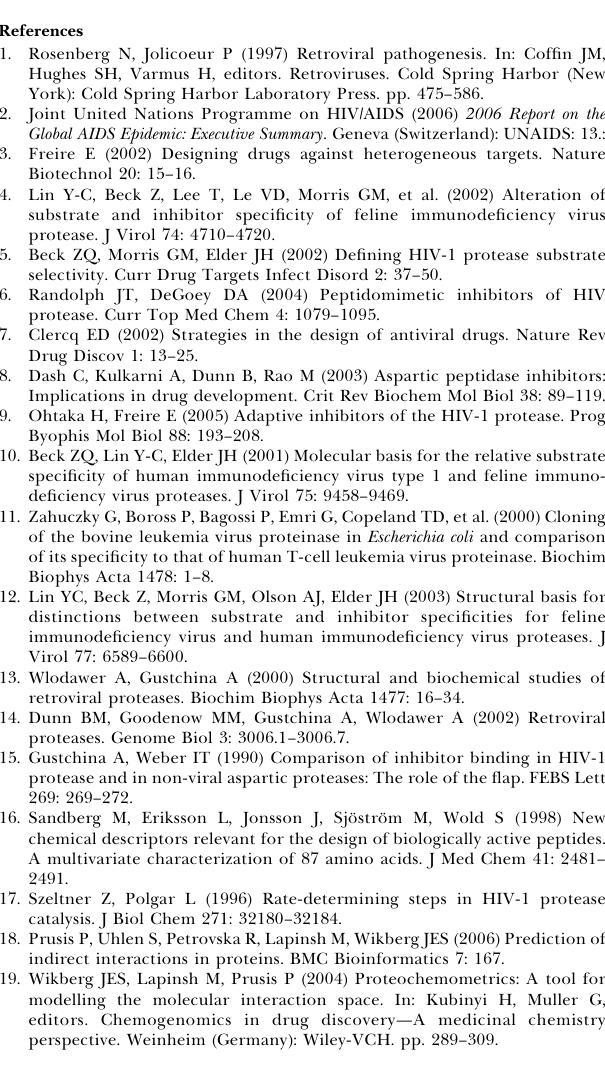
The Protein Data Bank (http://www.pdb.org) accession numbers for the proteins discussed in this paper are HIV-1 protease (1aid),